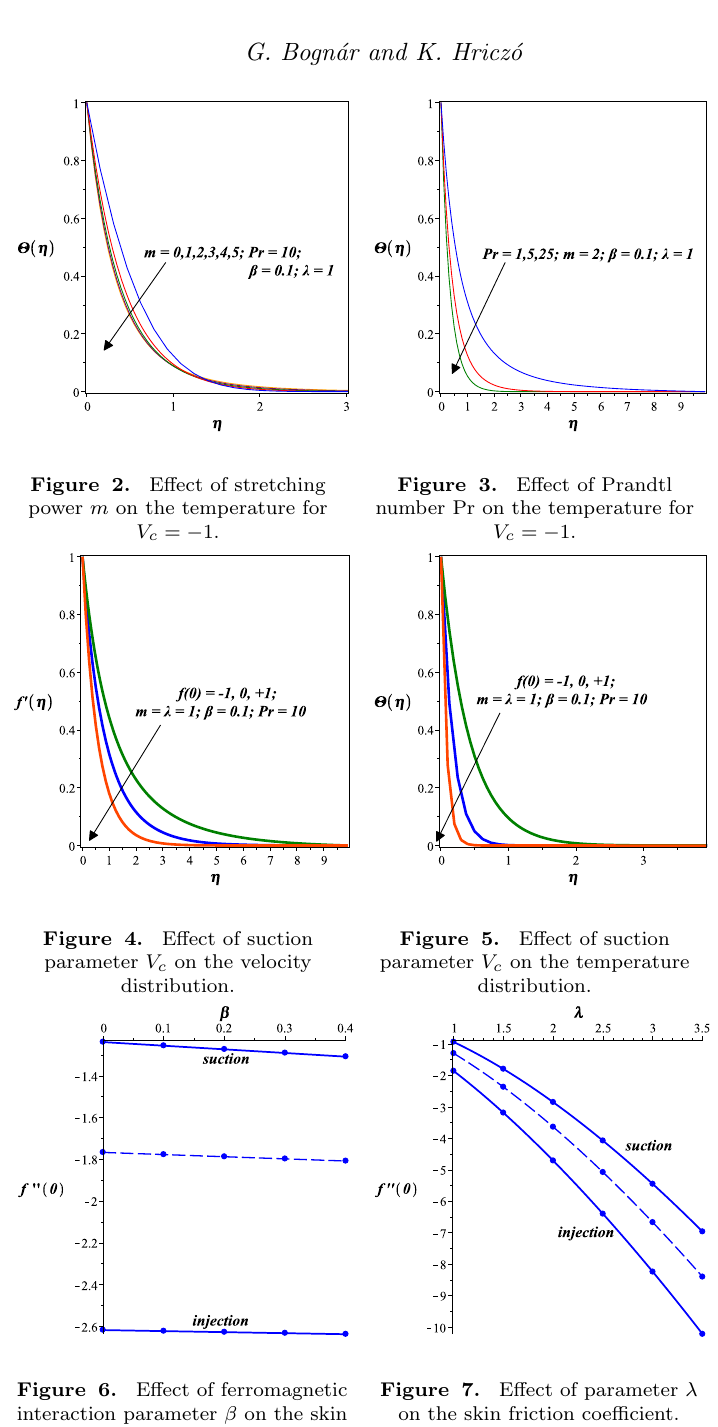
Figure 6. Effect of ferromagnetic Figure 7. Effect of parameter λ interaction parameter β on the skin on the skin friction friction coefficient.